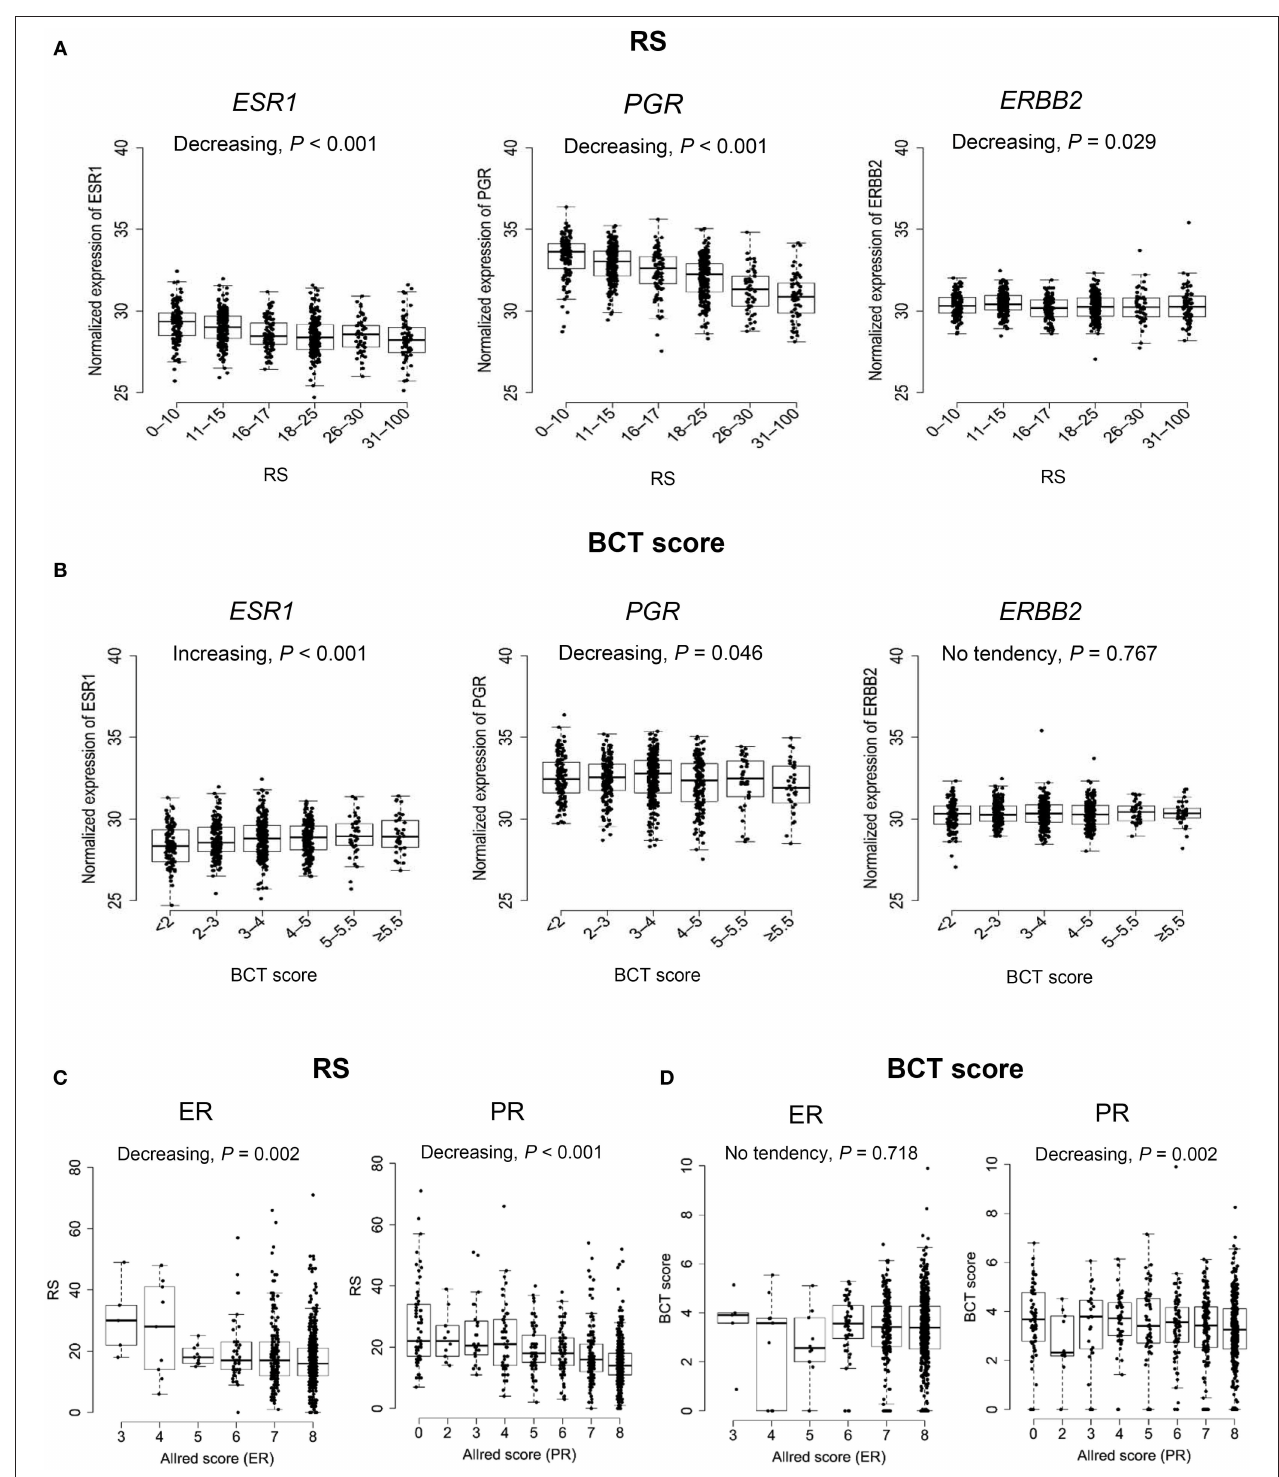
FIGURE 5 | Association between ER, PR, and HER2 expression and the BCT score or Oncotype DX RS. (A) Association of ESR1 , PGR , and ERBB2 gene expression with the RS and (B) the BCT score. (C) Correlation of ER and PR expression by Allred score with the RS and (D) the BCT score. The P -value of the trend was determined using the Jonckheere-Terpstra test (one-sided). The expression of ESR1 , PGR , and ERBB2 was measured by qRT-PCR. ER and PR Allred score were determined using immunohistochemistry.